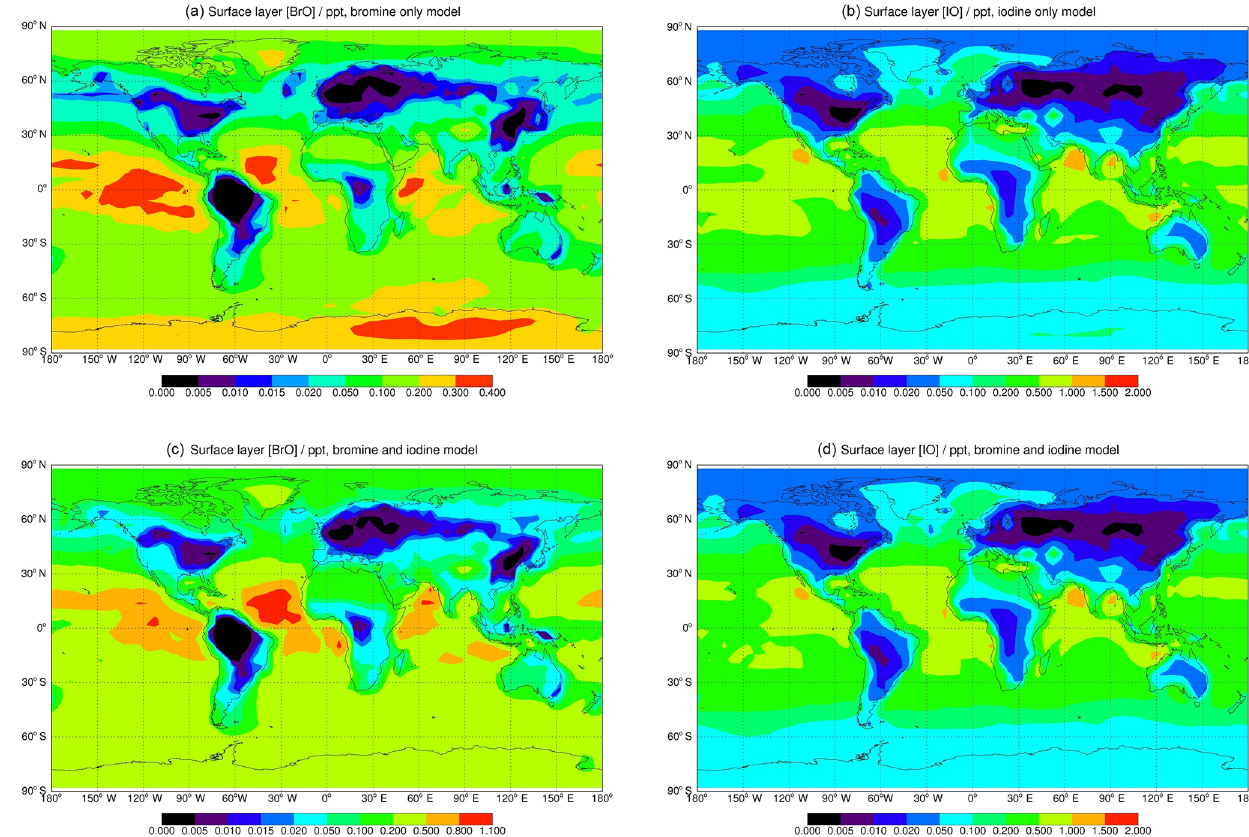
Figure 9. Annual surface layer mixing ratios (ppt) of BrO (a, c) and IO (b, d) radicals in GEOS-Chem for model runs with just bromine chemistry (a) , just iodine chemistry (b) and bromine and iodine chemistry combined (c, d)